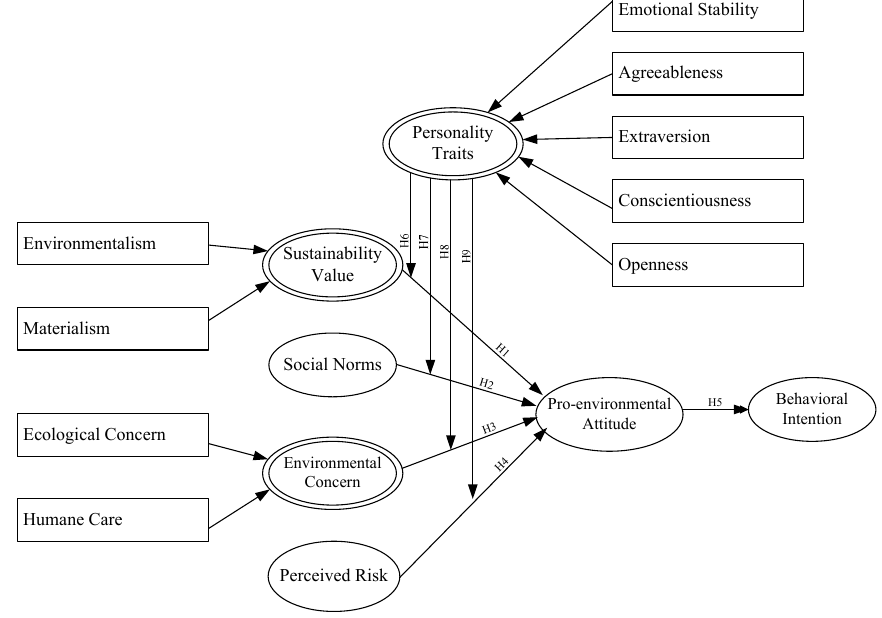
Figure 1. Conceptual of research model. H: Hypothesis.